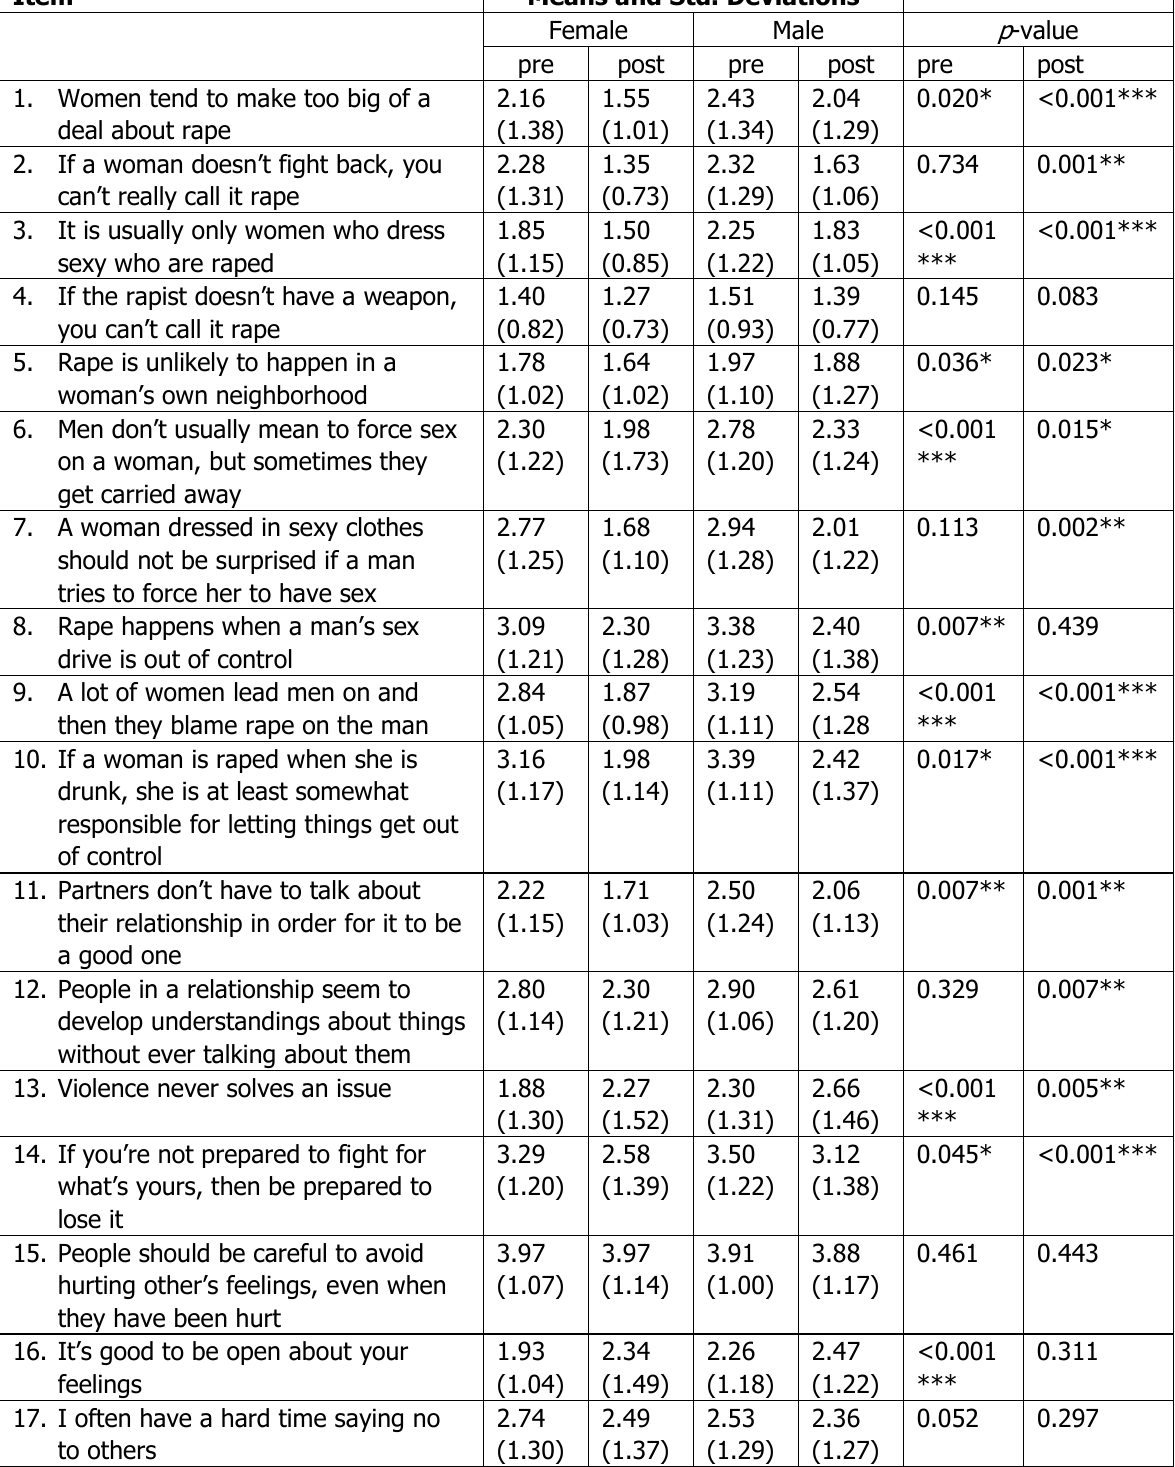
Means and Significance Levels by Gender on Pre and Post